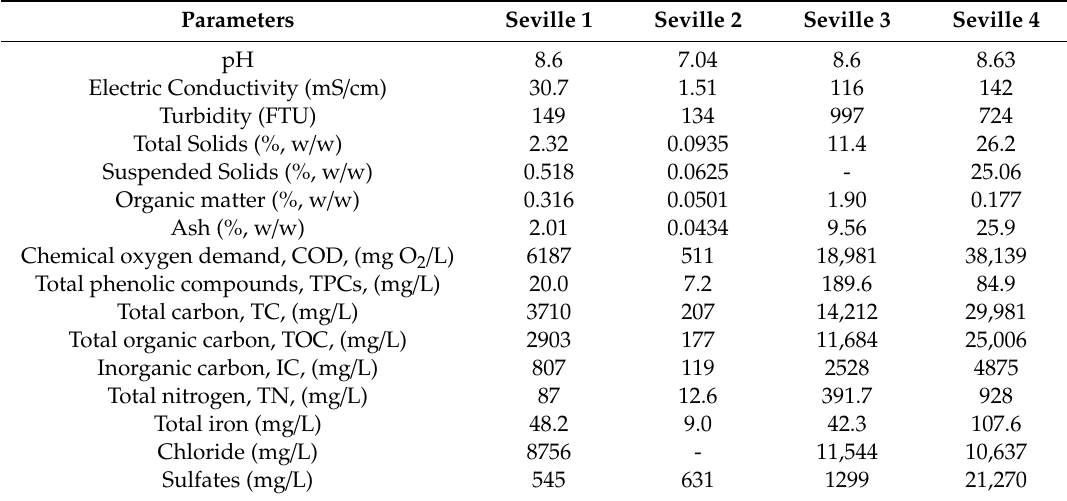
Table 1. Characterization of raw olive oil mill wastewater (OMW) from di ff erent evaporation ponds.